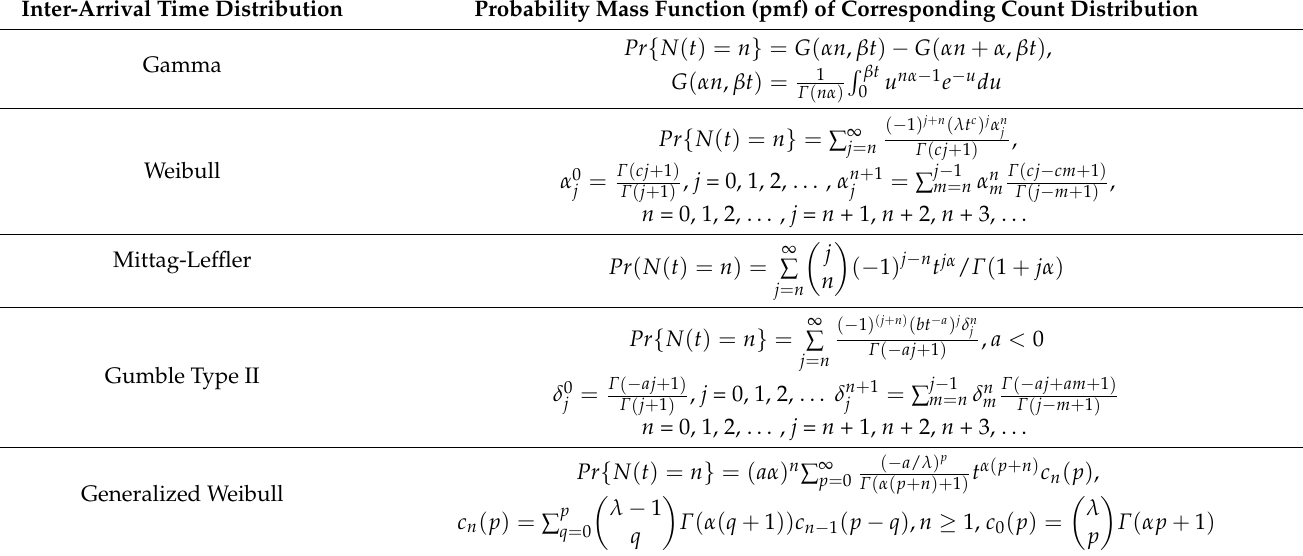
Table 1. Some existing count distributions in renewal